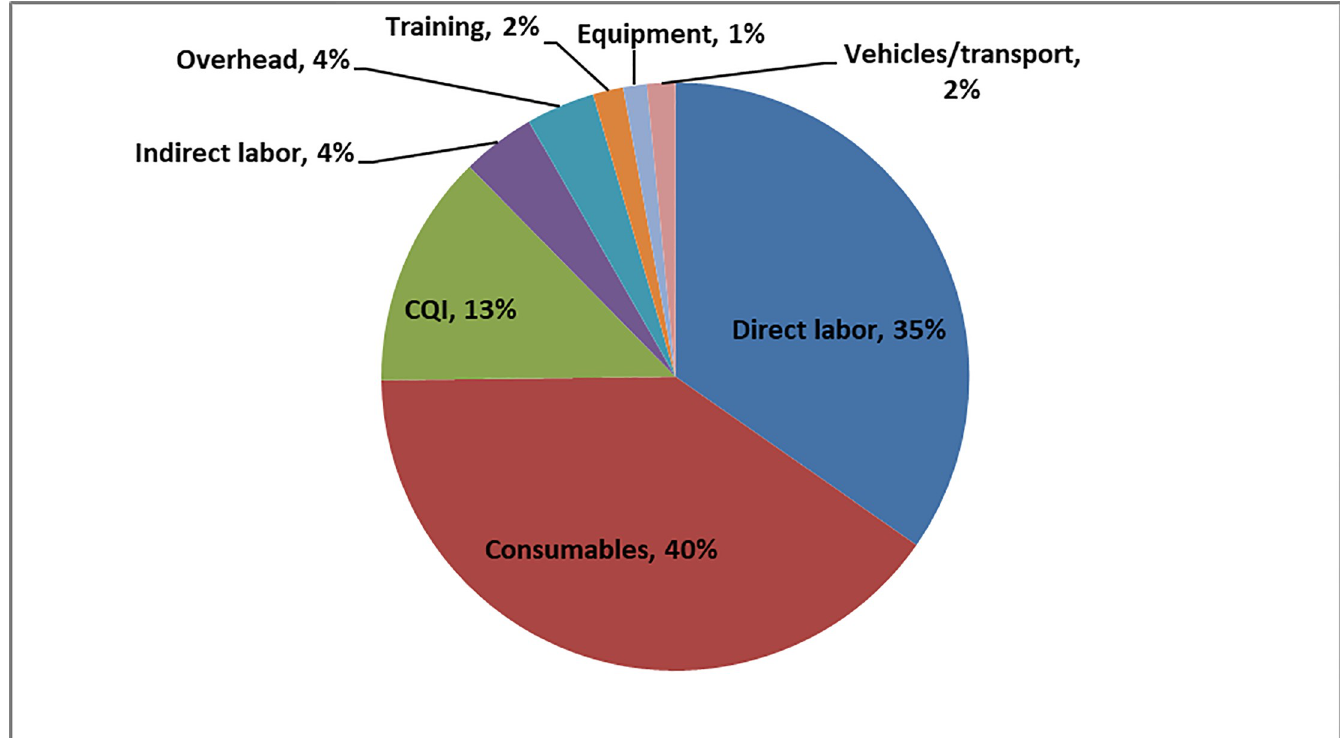
Fig 2. VMMC unit cost by major cost